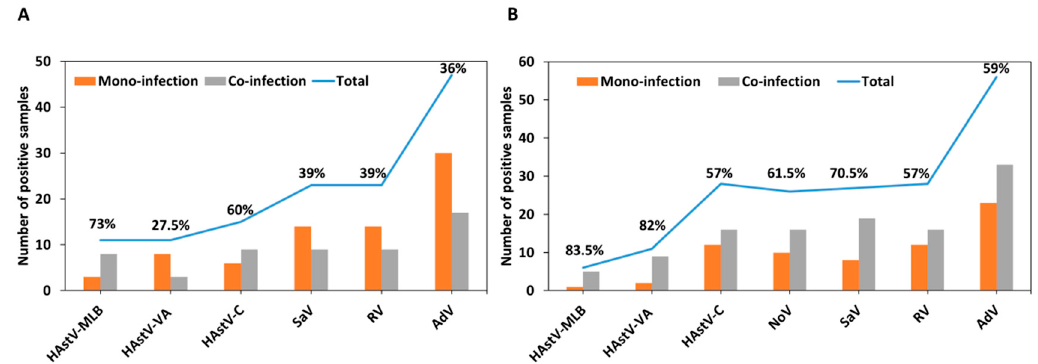
Figure 2. Number of cases identified in mono- and co-infections, respectively, for each virus in 2016 ( A ) and 2017 ( B ). Percentages indicate the proportion of co-infections. HAstV-MLB: MLB human astrovirus; HAstV-VA: VA human astrovirus HAstV-C: classic human astrovirus; NoV: norovirus: GI: genogroup I; GII: genogroup II; SaV: sapovirus; RV: rotavirus; AdV: adenovirus.